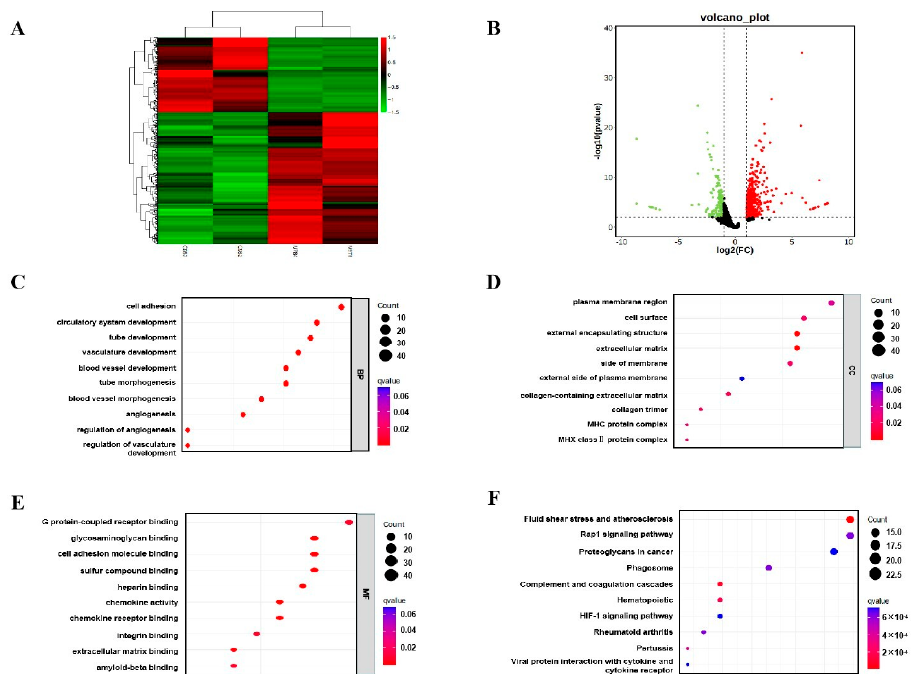
Figure 5. Effects of melatonin supplementation on the t ranscriptome of placental tissue. ( A ) Cluster analysis. ( B ) Expression difference analysis. ( C ) Analysis of biological processes in GO. ( D ) Analysis of cellular components in GO. ( E ) Analysis of molecular function in GO. ( F ) KEGG enrichment anal- ysis.